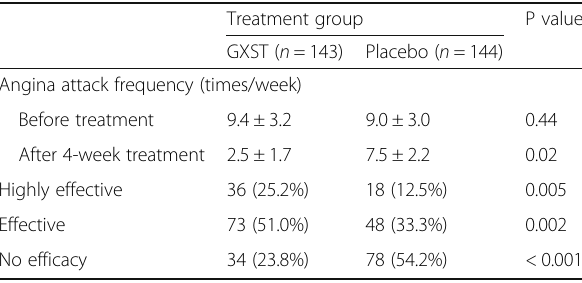
Table 2 Primary efficacy evaluation Treatment